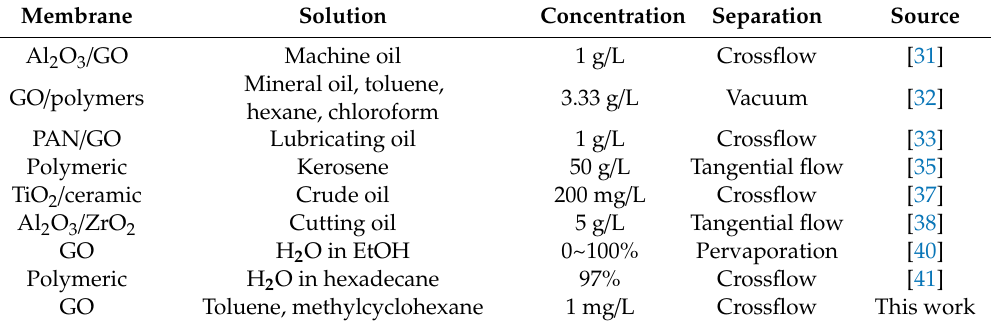
Table 1. List of recent works in the separation field employing di ff erent kinds of membranes, techniques, and concentrations of oil-in-water emulsions. The aim of this table is to underline the lack of tests in the literature of filtrations below the solubility limit, avoiding the presence of emulsions and surfactants. Membrane Solution Concentration Separation Source Al 2 O 3 / GO Machine oil 1 g / L Crossflow [31] Mineral oil, toluene, 3.33 g / L Vacuum [32] GO / polymers hexane, chloroform PAN / GO Lubricating oil 1 g / L Crossflow [33] Polymeric Kerosene 50 g / L Tangential flow [35] TiO 2 / ceramic Crude oil 200 mg / L Crossflow [37] Al 2 O 3 / ZrO 2 Cutting oil 5 g / L Tangential flow [38] GO H 2 O in EtOH 0~100% Pervaporation [40] Polymeric H 2 O in hexadecane 97% Crossflow [41] GO Toluene, methylcyclohexane 1 mg / L Crossflow This